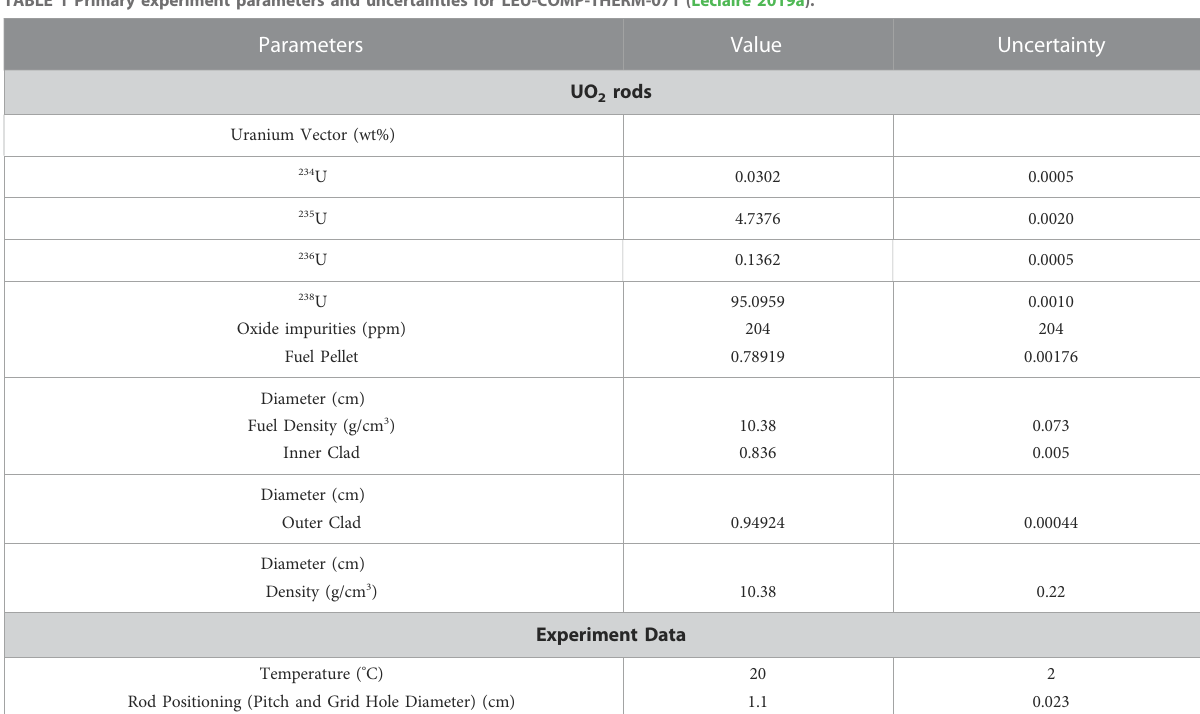
Rod Positioning (Pitch and Grid Hole Diameter)